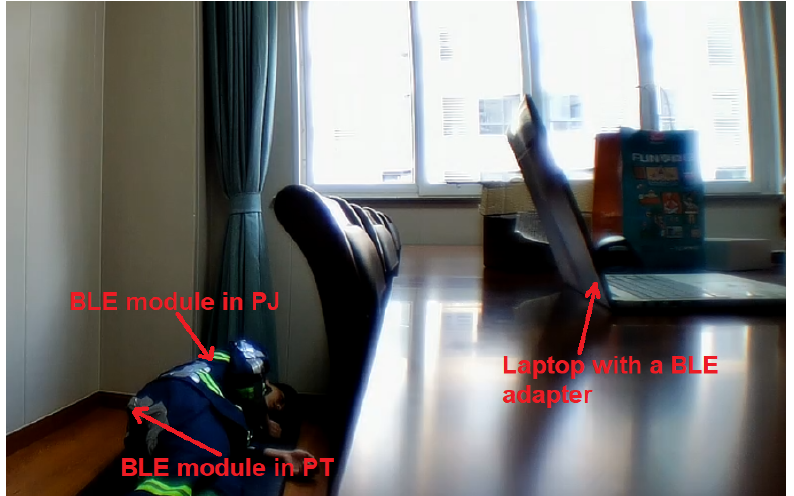
Figure 8. Data collection, via BLE 4.2 wireless transmission to a laptop, of IMU data from the PJ and